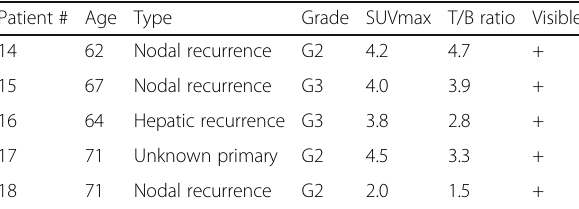
Table 2 CXCR4-targeted PET imaging of patients with recurrent breast cancer with corresponding clinical data Patient # Age